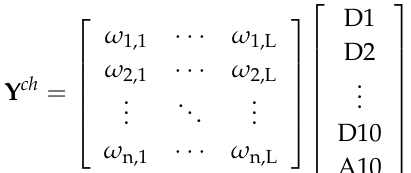
Figure 6. Flowchart of the proposed method.